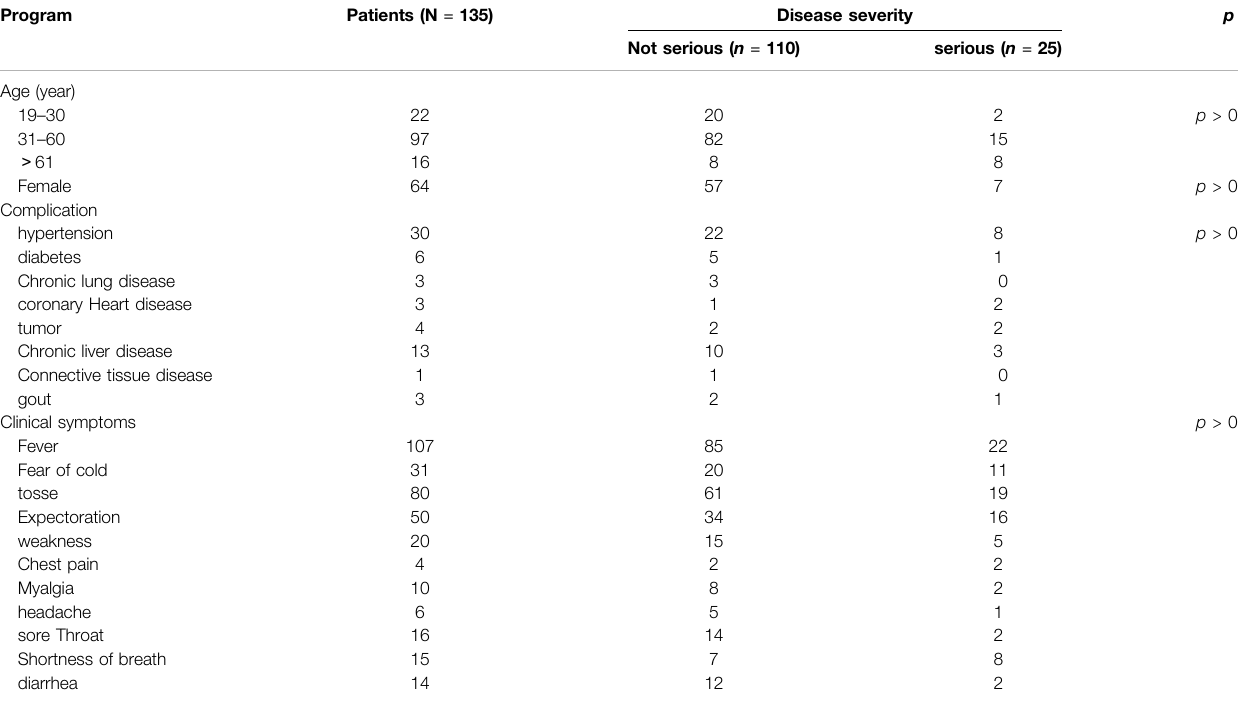
TABLE 1 | General_information_of_135_novel_coronavirus_infected_pneumonia_patients. Program